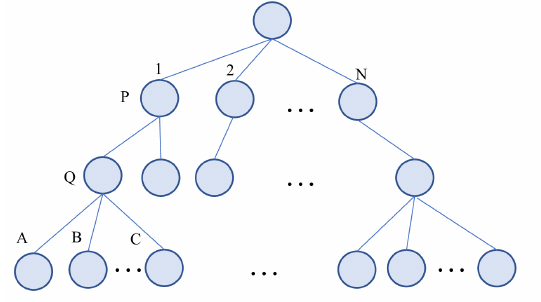
Figure 5. The N -tree structure of a